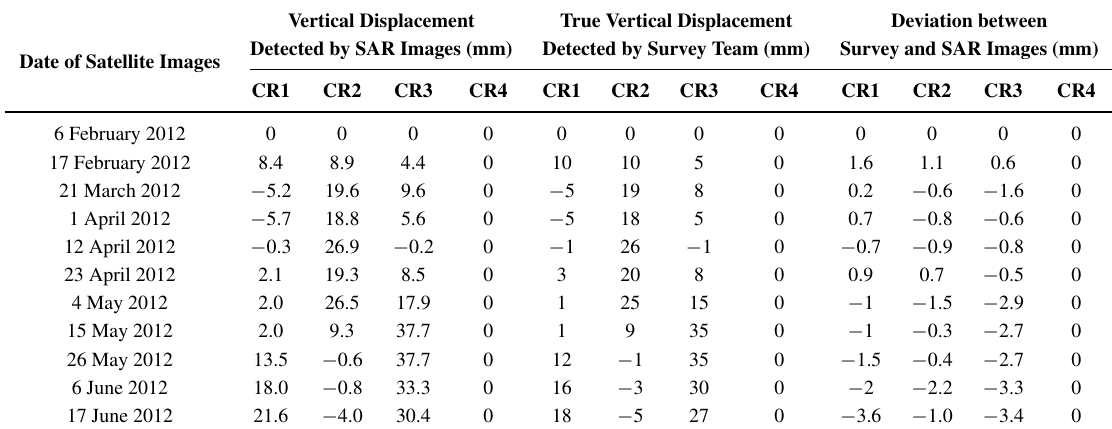
Table 2. The comparison of vertical displacements between SAR images and those surveyed.